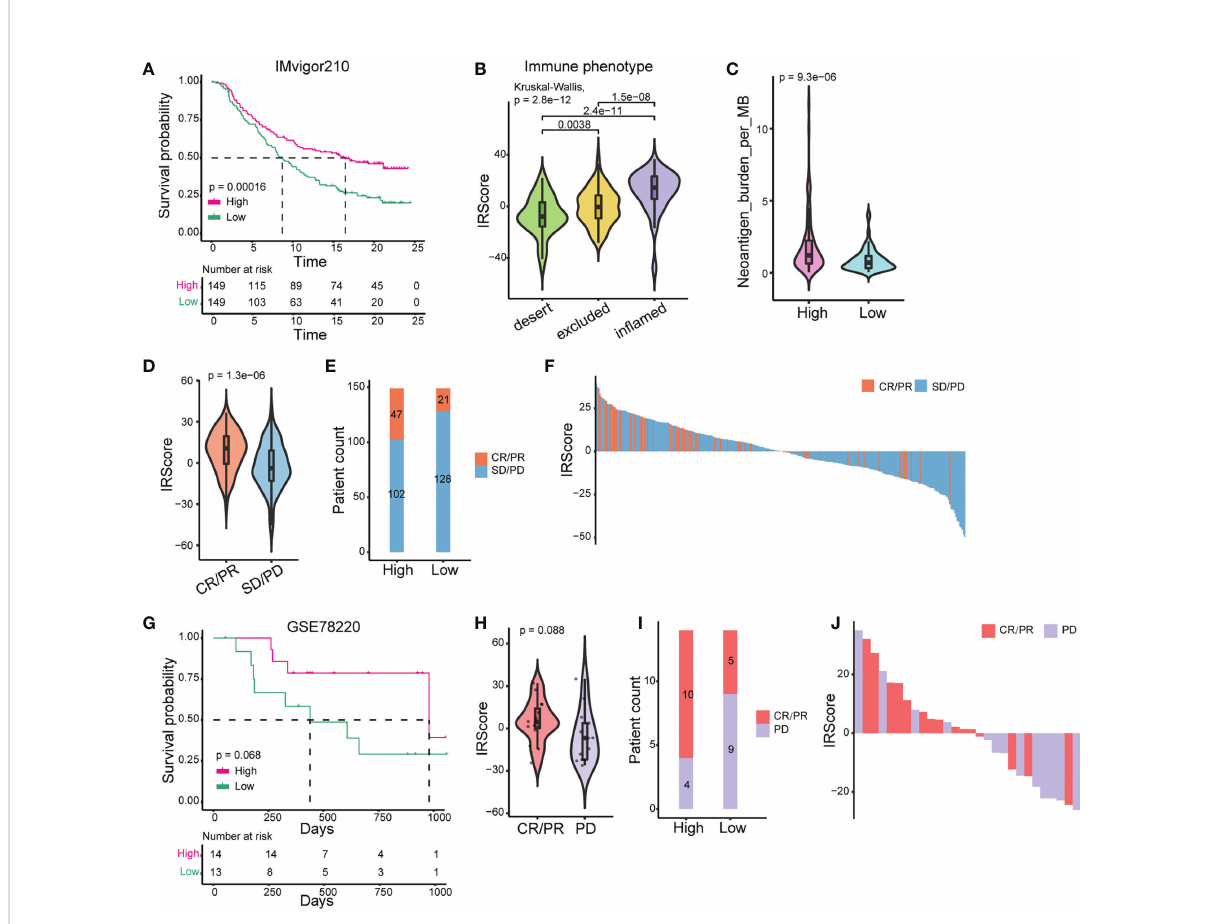
FIGURE 2 Prediction of patients ’ responses to immunotherapy by IRScore. (A) Kaplan-Meier curve of survival probability based on IRScore groups in IMvigor210 cohort. (B) Comparison of IRScore among different immune phenotypes. (C) Comparison of neoantigen burden between high and low IRScore groups. (D) Violin plots of IRScore between CR/PR and SD/PD. (E) Compositions of patients ’ responses to PD-L1 inhibitor treatment between high and low IRScore groups (P-value< 0.05, Fisher ’ s exact test). (F) Waterfall plots illustrating IRScore according to immunotherapeutic responses in IMvigor210 cohort. (G) Kaplan-Meier curve of survival probability based on IRScore groups in GSE78220 cohort. (H) Violin plot of IRScore between CR/PR and PD. (I) Compositions of patients ’ responses to PD-1 inhibitor treatment in the two IRScore groups. (J) Waterfall plot illustrating IRScore according to immunotherapeutic responses in GSE78220